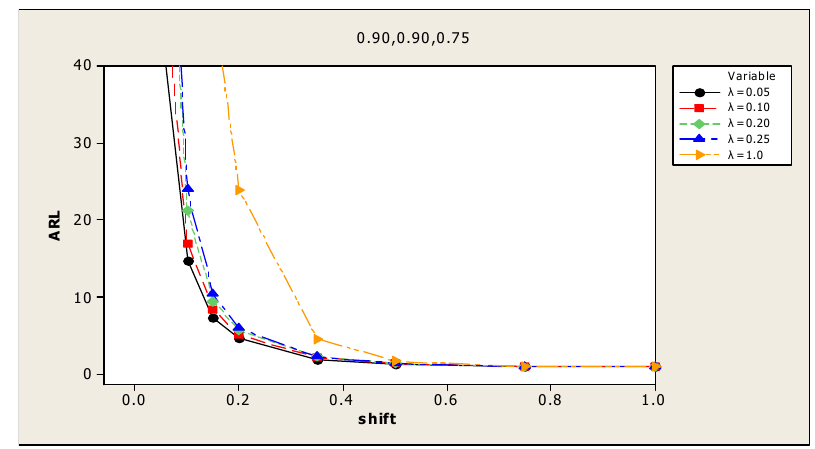
Figure 4. ARL curves when ρ yu = 0.9, ρ yv = 0.9, ρ uv = 0.75 at above values of λ .